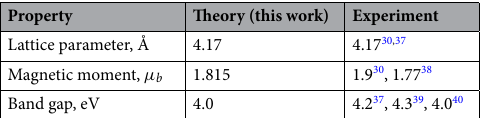
Table 1. Calculated properties of bulk NiO and available experimental data.